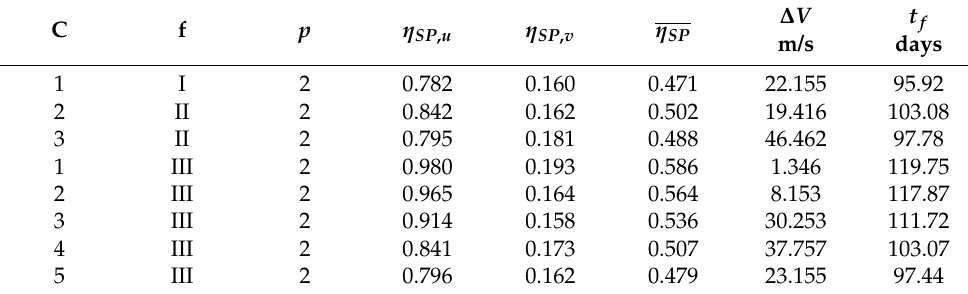
Table 2. SEL2 escapes performance—fixed C 3 = 0.2 ( km/s ) 2 , free t f .